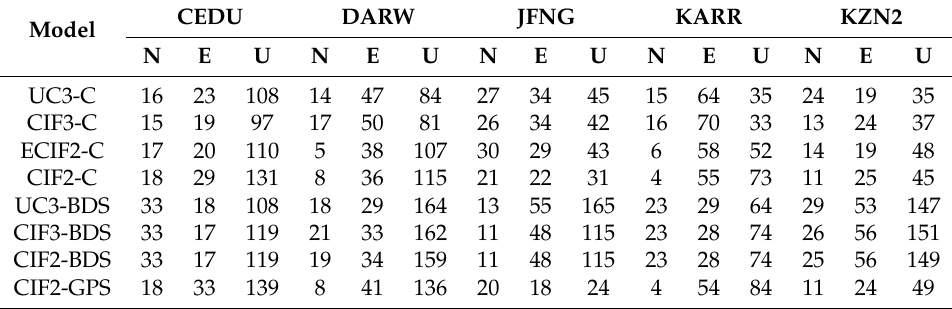
Figure 10. The positioning errors in different combined models for the daily solution at different stations. ( a ) The positioning errors at CEDU; ( b ) The positioning errors at DARW; ( c ) The positioning errors at JFNG; ( d ) The positioning errors at KARR; and ( e ) The positioning errors at KZN2. Table 5. Accuracies for different combined models with the daily solution in North (N), East (E), Up (U) directions